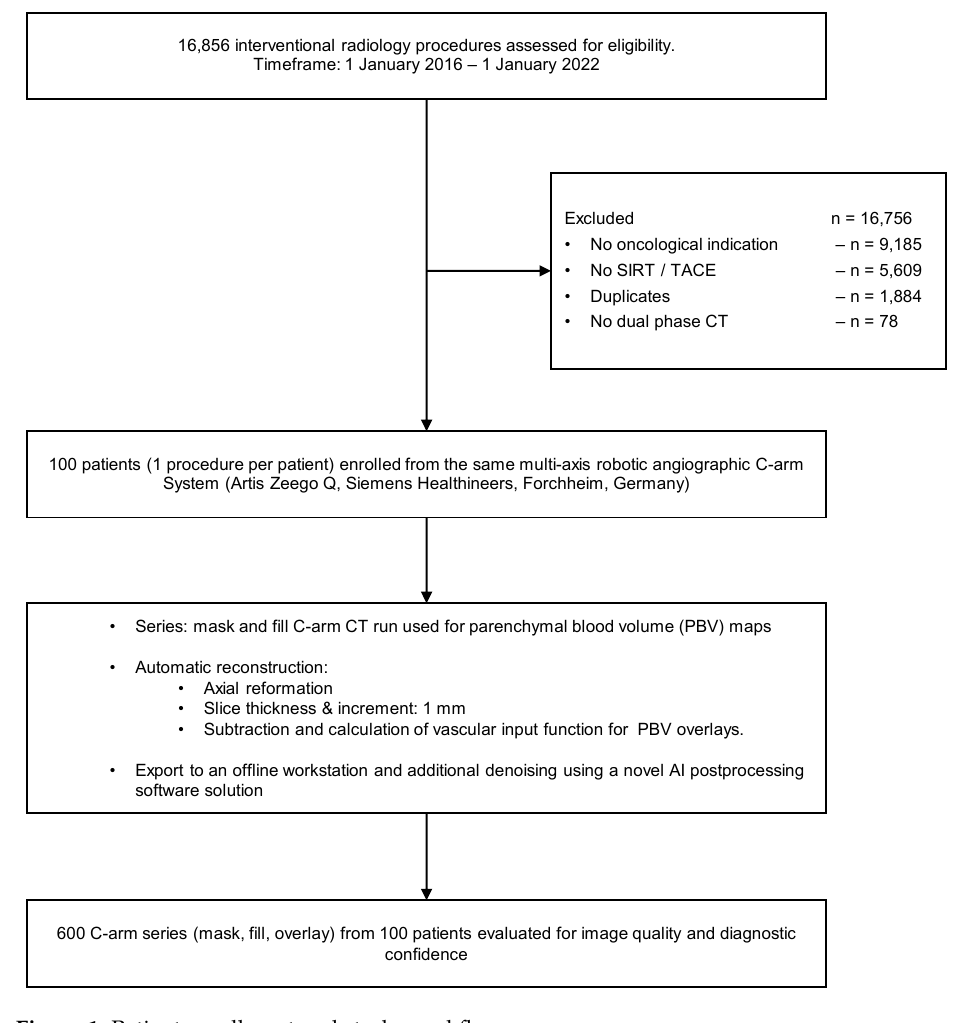
Figure 1. Patient enrollment and study workflow.